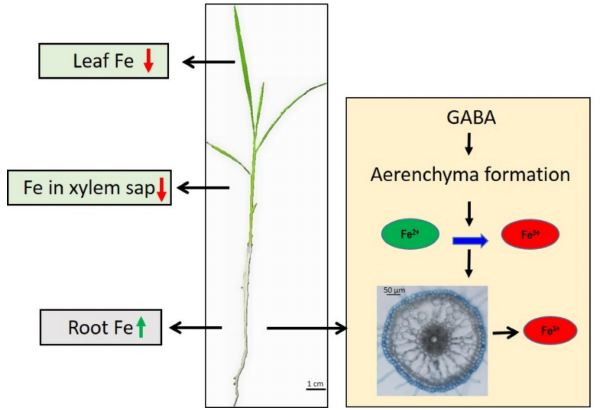
Figure 7. A proposed model for GABA-mediated Fe homeostasis in rice seedlings. GABA treatment induced aerenchyma formation in roots and oxidized soluble Fe 2+ into insoluble Fe 3+ and Fe 3+ was precipitated in epidermal cells of roots, and therefore GABA inhibited the transportation of Fe from roots to shoots. The green arrow denotes increase of Fe content and the red arrows denote decrease of Fe content. The blue arrow denotes Fe 2+ was oxidized into Fe 3+